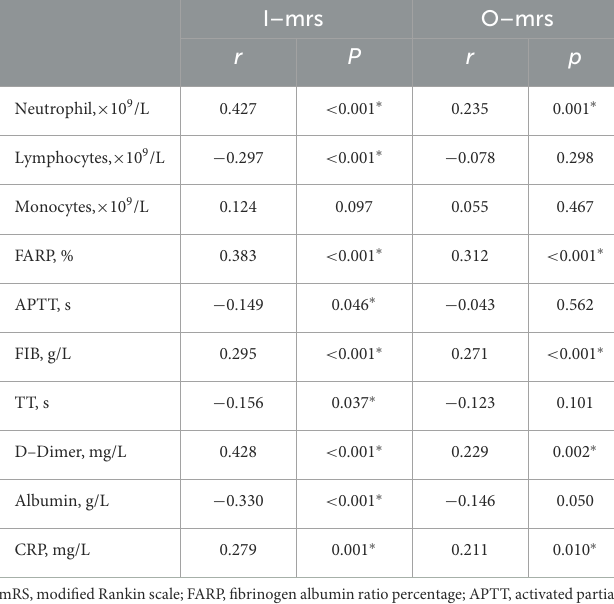
no significant relationship among sex, hypertension, blood monocyte count, blood lymphocyte count, APTT, or D-dimer level with the final mRS ( P > 0.1). The multivariate model showed that FARP was